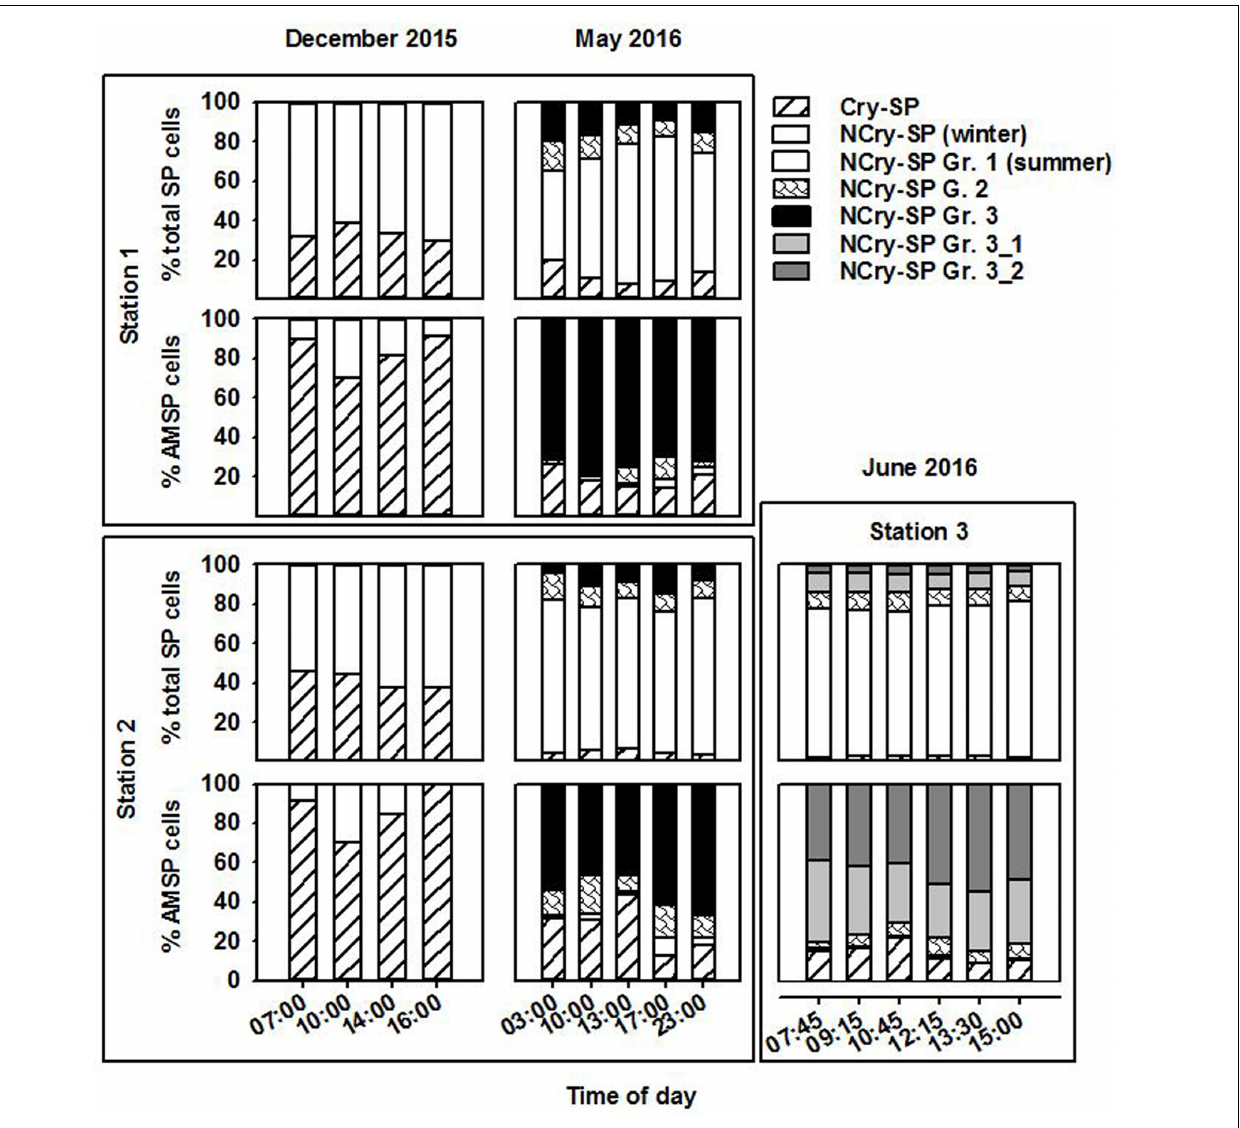
FIGURE 2 | Relative contribution of the different groups (Gr.) distinguished on the flow cytometer to the total SP and AMSP pool at station 1, station 2, and station 3 in December 2015, May 2016, and June